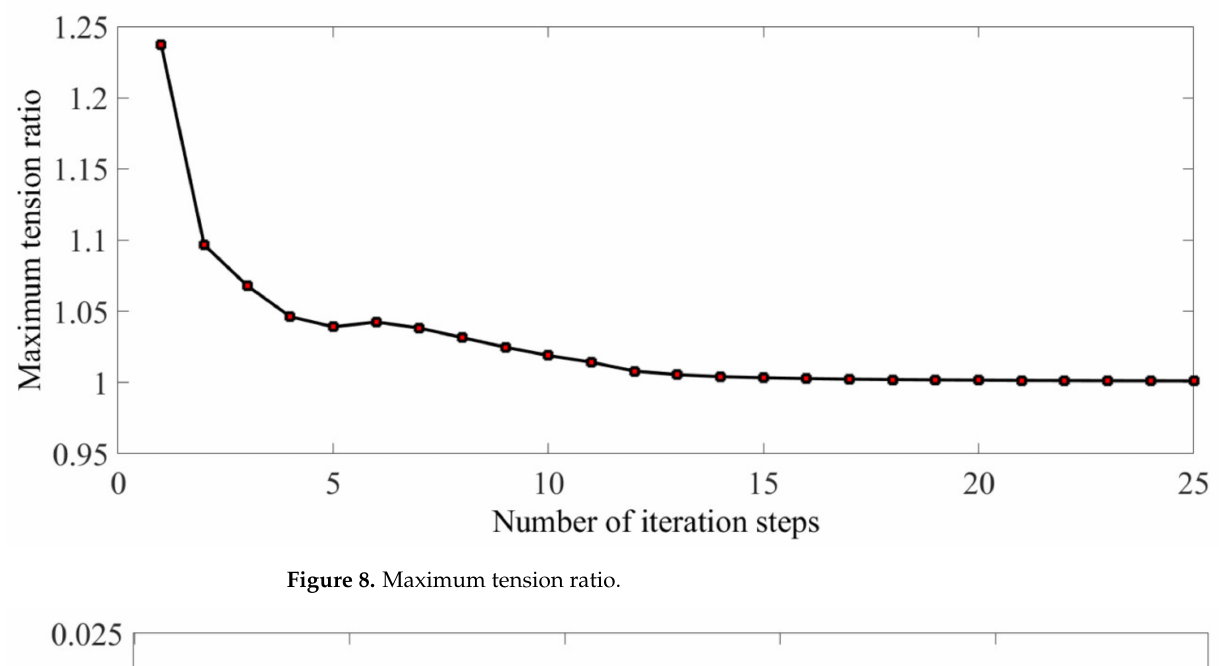
Figure 8. Maximum tension ratio.